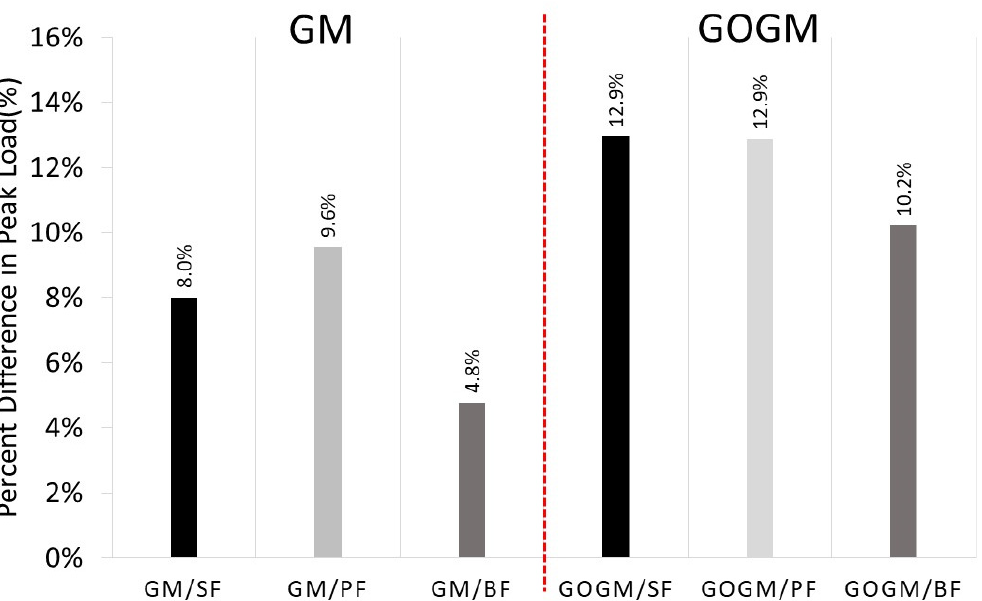
Figure 9. Percentage difference in peak load due to increasing loading rate comparing between GM and GOGM .